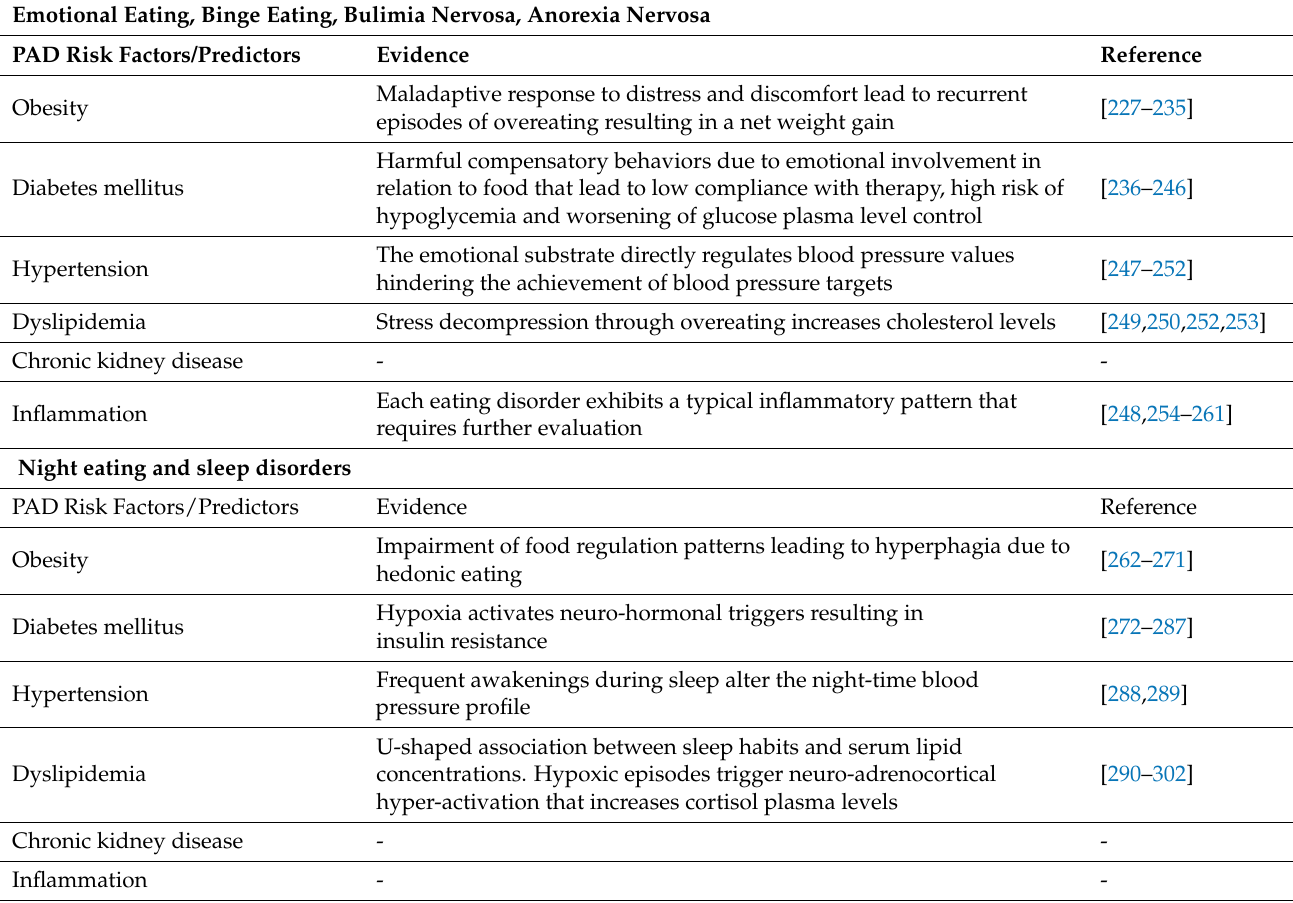
Table 2. Interplay between non-dietary Risk factors and Predictors of PAD with